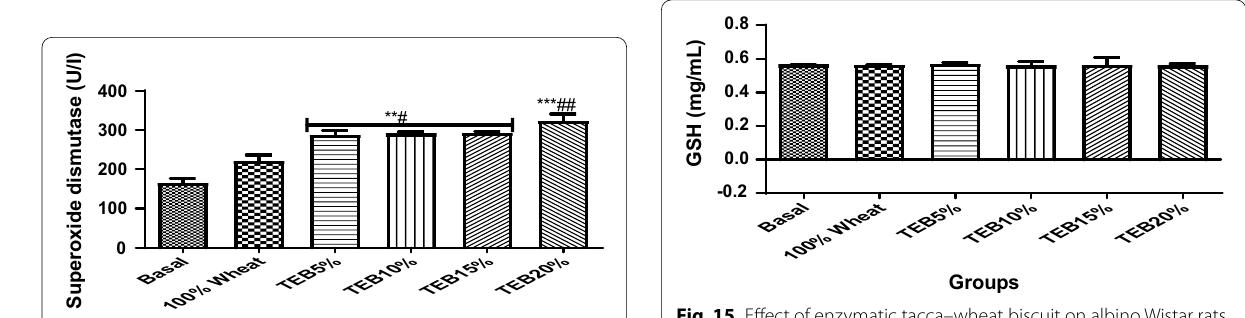
Fig. 15 Effect of enzymatic tacca–wheat biscuit on albino Wistar rats by reduced glutathione (GSH) activities.100% Wheat: Rats fed with 100% wheat flour biscuit, TEB5%: Rats fed with 5% enzymatic tacca flour 95% wheat flour biscuit, TEB10%: Rats fed with 10% enzymatic + 95% tacca flour 90% wheat flour biscuit, TEB15%: Rats fed with 15% + + enzymatic tacca flour 85% wheat flour biscuit, TEB20%: Rats fed + with 20% enzymatic tacca flour